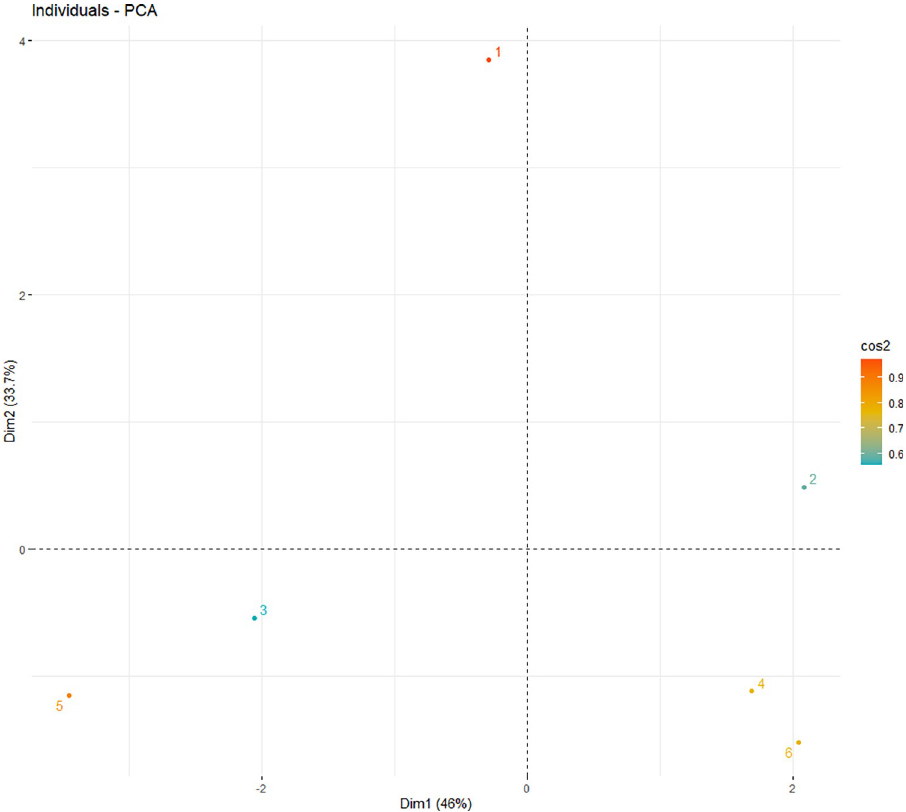
Fig 2. Principal component analysis (PCA) biplot of individuals. Legend: 1—C200; 2—S200; 3—C50; 4—S50; 5— C10; 6—S10; cos2 –square coordinates, quality of representation of the variables; Dim1 –principal component 1; Dim2 –principal component